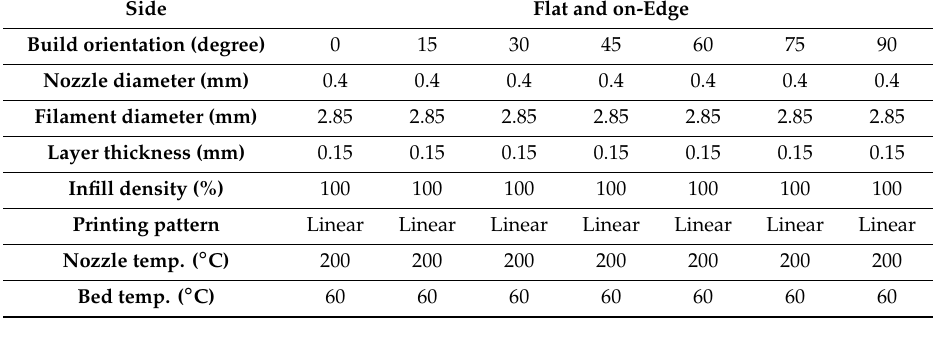
Figure 6. Schematic of sample orientation in ( a ) flat side and ( b ) on-edge side. Table 3. Printing parameters.